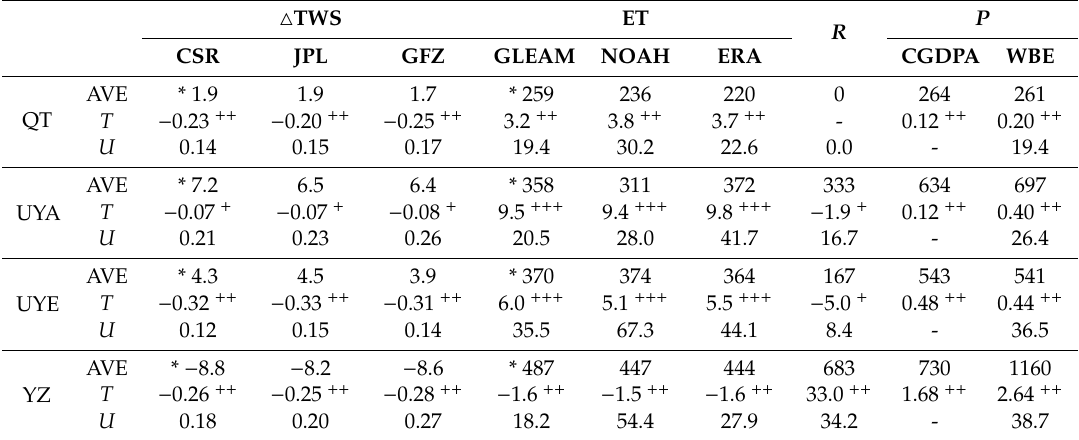
Table 1. General analyses of each component in WBE. “AVE”, “T”, and “U” represent the annual average value (unit: mm / year), the interannual trend (unit: mm / year 2 ), and the uncertainty (unit: mm / year) calculated from di ff erent products for each component, respectively. U ∆ TWS and U ET are calculated in the triple collocation method, presenting the uncertainty of each ∆ TWS and ET product, respectively.